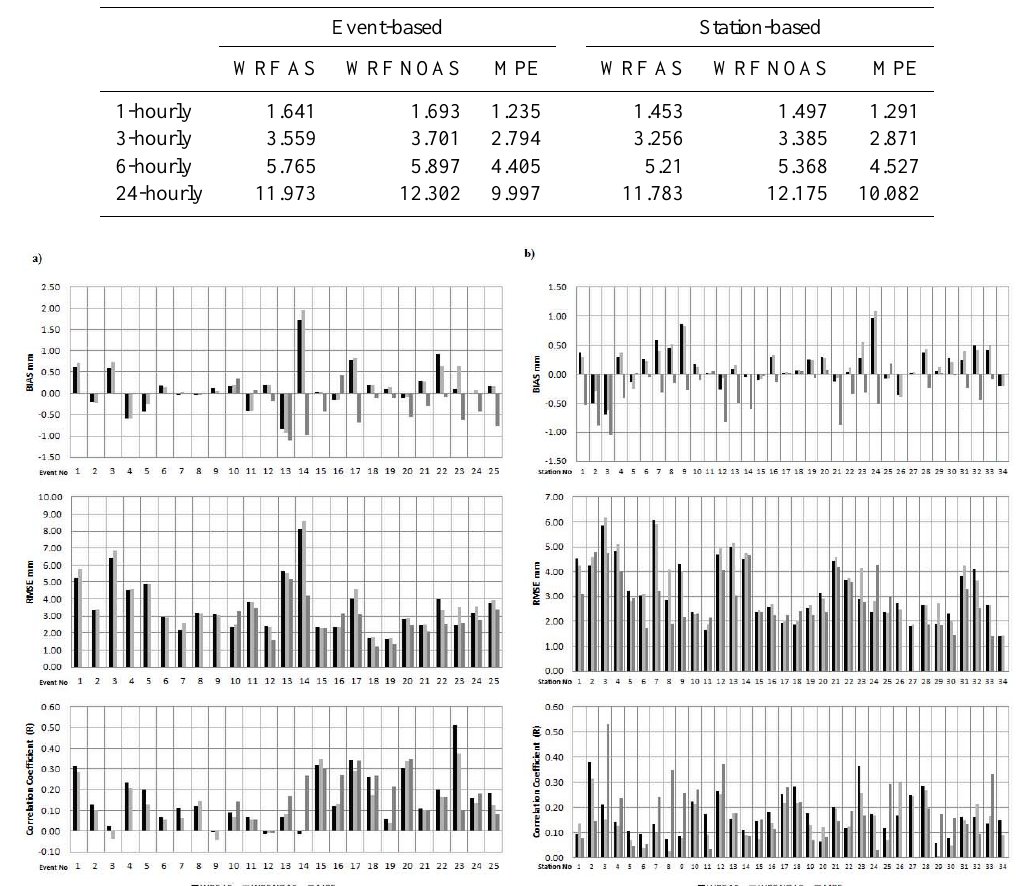
Fig. 7. Bias, RMSE, and correlation coefficient ( R ) of WRF AS, WRF NOAS, and MPE at 3h interval are shown in (a) for each event and (b) for each